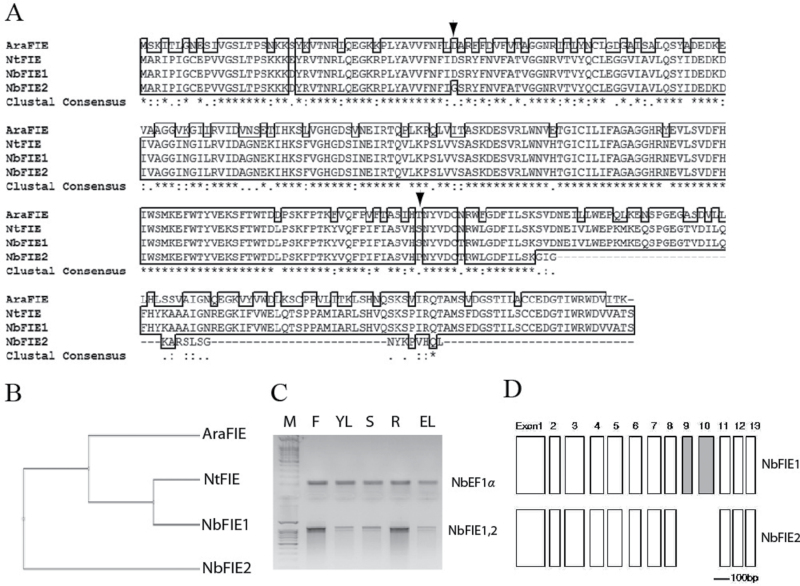
Cloning and expression patterns of NbFIE1 and NbFIE2 genes. (A) Sequence alignment and (B) phylogenetic analysis run by the Bioedit program. AraFIE, Arabidopsis FIE protein; NtFIE, FIE homologue in N. tabaccum. The arrowheads marked the two amino-acid residues in the common coding region of NbFIE1 and NbFIE2. (C) RT-PCR of the organ expression profiles of the NbFIE1 and NbFIE2 genes in 7-week-old plants: F, opened flowers; YL, young leaves; S, stem; R, roots; EL, expanded leaves; M, 100-bp DNA ladder marker. The NbEF1α gene was used as the internal standard. (D) Schematic depictions of the exon structures of NbFIE1 and NbFIE2 genes. Introns are not shown due to uncertainty of sequences and/or size appearing in some of them.